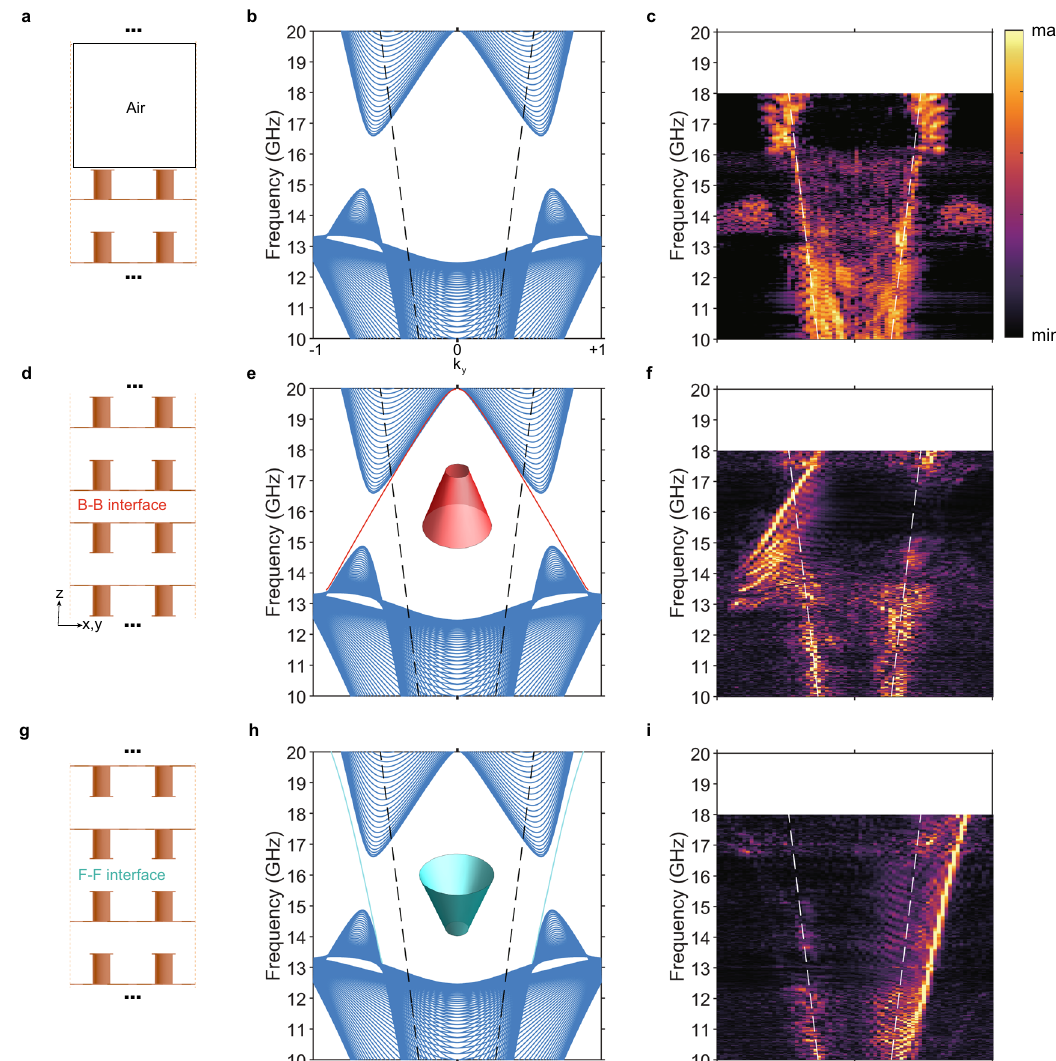
Fig. 3 Experimentally characterizing interface states between momentum-space toroidal moments (MTMs). a Con fi guration for bulk state mapping. There are 20 unit cells used in the experiment. Near fi eld raster-scanning is used to probe the bulk state exponentially decaying tails. b Projected bulk bands on the k x ¼ 0 plane with discretized k z . c Experimentally mapped bulk states corresponding to the con fi guration as shown in a , where modes in air exist across the complete gap. d Con fi guration for Back – Back (B – B) interface states. On each side there are 10-unit-cell used in the experiment. e Back – Back interface states (red solid line) run through the complete gap. The inset shows the 3D view of the interface state. f Experimentally mapped Back – Back interface states from Fourier-transforming phase-distribution (See Supplementary Fig. 4). g – i Similar to d – f but for the Face – Face (F – F) interface. Dashed black/white lines indicate light corresponding band structure along high symmetry lines in the momentum space with the fi rst Brillouin zone (FBZ) shown in Fig. 2e. By introducing a small metallic bar in the vertical as shown in direction to slightly break the mirror symmetry M z Fig. 2b, the nodal ring becomes fully gapped, with the resulting band structure presented in Fig. 2d. The underlying topological features of the gapped nodal ring are studied via Wilson loop calculations, which give the Zak phase accumulated along þ k z direction (Fig. 2f, for details see Supplementary Note 1 and Supplementary Fig. 1a). The corresponding hybrid Wannier center for the two bands with frequencies below the bulk bandgap along Γ XM Γ is shown in Fig. 2g. Similar to staggered graphene, the Wannier center approximately approaches to 0 or π in the with the direction de fi ned in Supplementary Fig. 1b (see Sup-